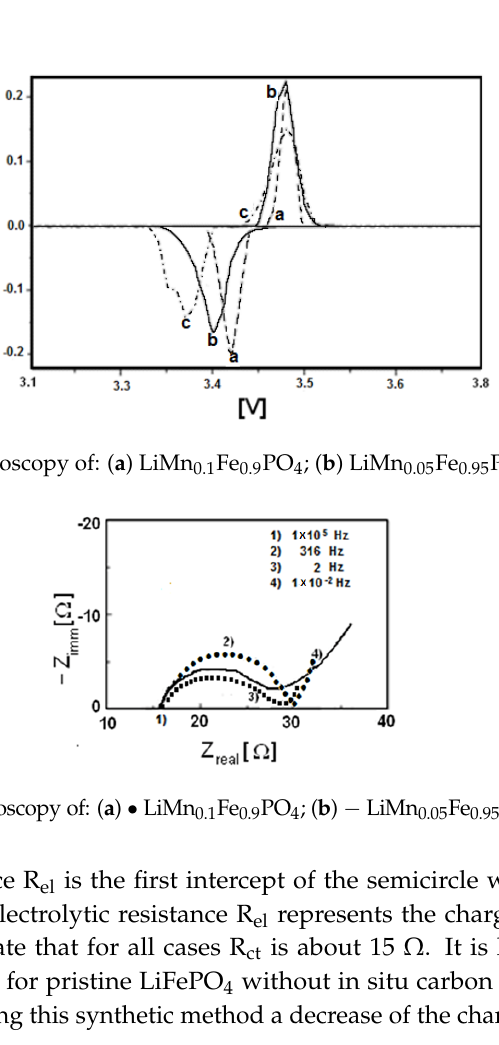
Table 5. Pseudo ‐ diffusion coefficients D (in cm 2 s − 1 ).